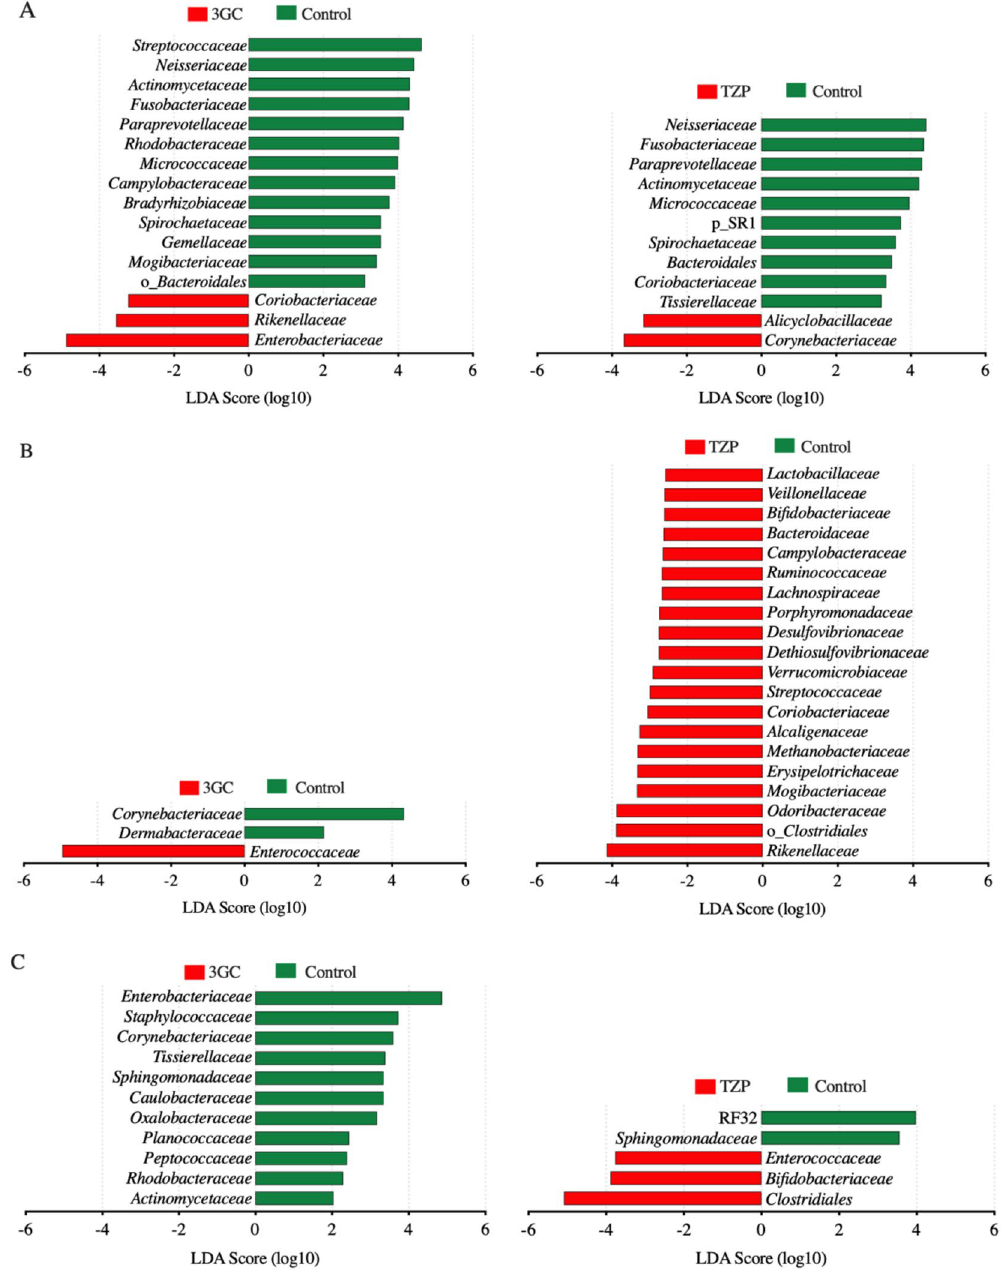
Figure 3. Bacterial families in the ( A ) endotracheal, ( B ) perineal, and ( C ) faecal microbiota showing significantly different abundances in the 3GC and TZP groups compared to the control group after 48 h (3GC-third-generation cephalosporins, TZP-piperacillin/tazobactam, control-no β-lactams). Data were obtained using LEfSe analyses between each antibiotic treatment and the control group. The histograms show the linear discriminant analysis (LDA) scores computed for each bacterial